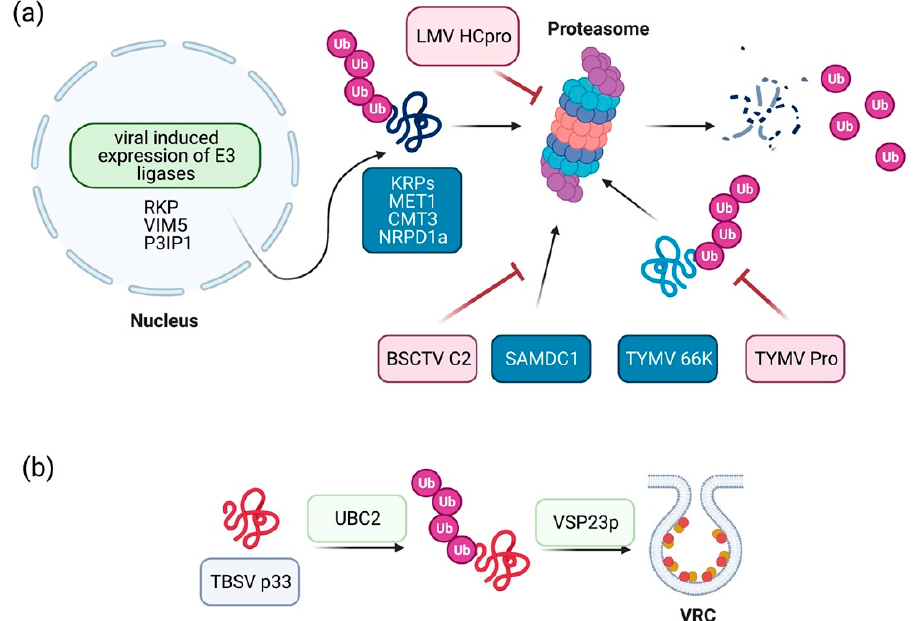
Figure 1. Viral manipulation of the host UPS. ( a ) Viruses can inhibit the function of the proteasome either by direct interaction with its subunits (LMV HCpro) or by induction of the expression of plant E3-Ub ligases (RKP, VIM5, and P3IP1). This induction leads to the subsequent degradation of antiviral host factors. Furthermore, virus proteins (BSCTV C2) can interact directly with host factors (SAMDC1) to prevent its proteasomal degradation, or TYMV Pro can counteract ubiquitination via its deubiquitinase activity. ( b ) Viruses form viral replication complexes (VRC) using membranous structures from the host. TBSV uses the UPS in order to facilitate the formation of VRCs.